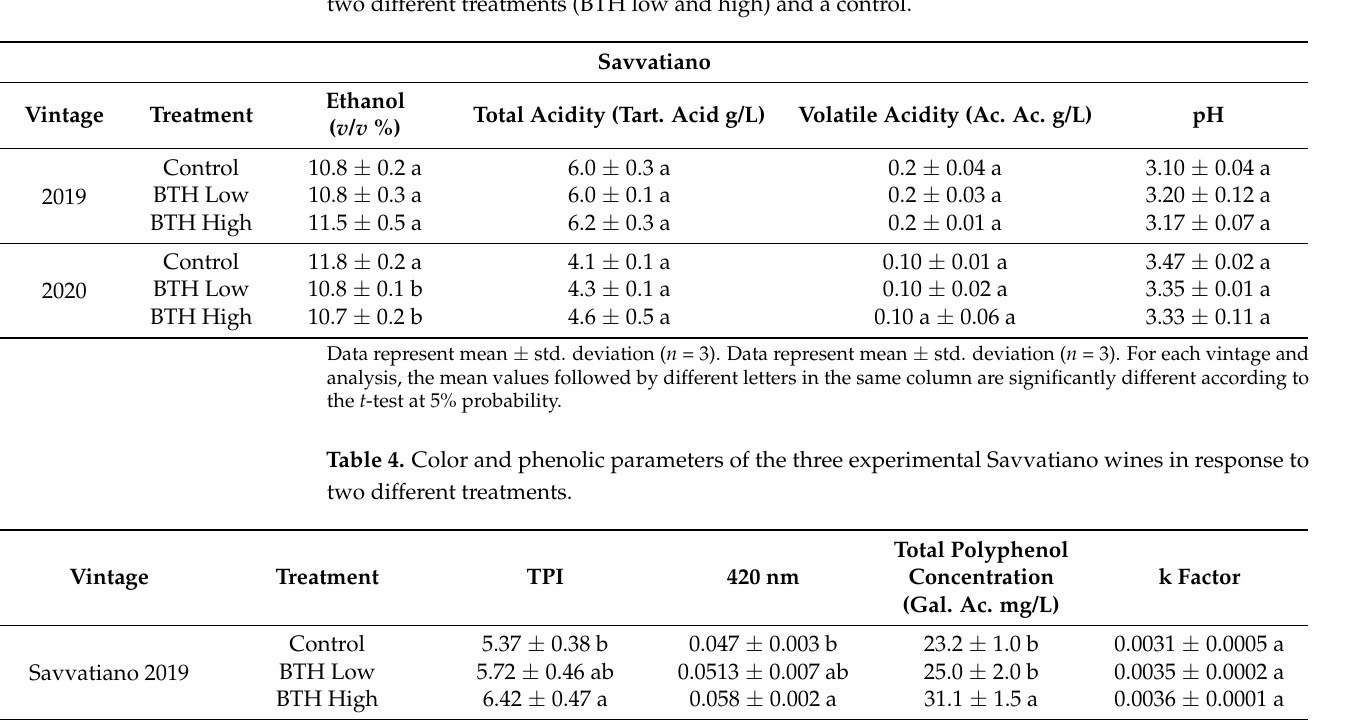
Table 3. Conventional wine analysis parameters of experimental Savvatiano wines in response to two different treatments (BTH low and high) and a control.